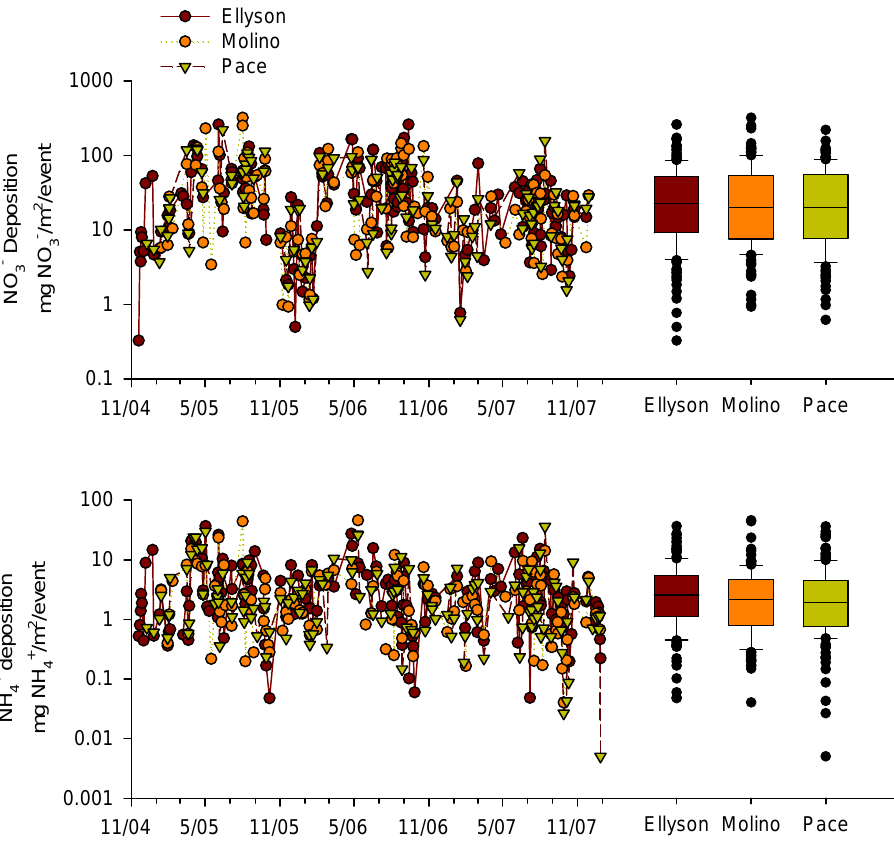
) deposition (mg NO 3 /m 2 /event) (top panel) and ammonium (NH + Fig. 4. Nitrate (NO − 3 in Fig.